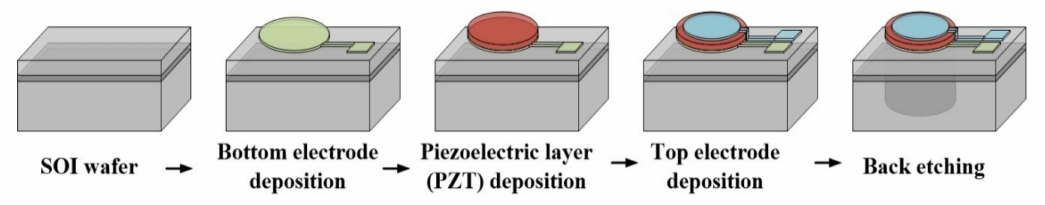
Figure 5. Fabrication process flow of the proposed PZT